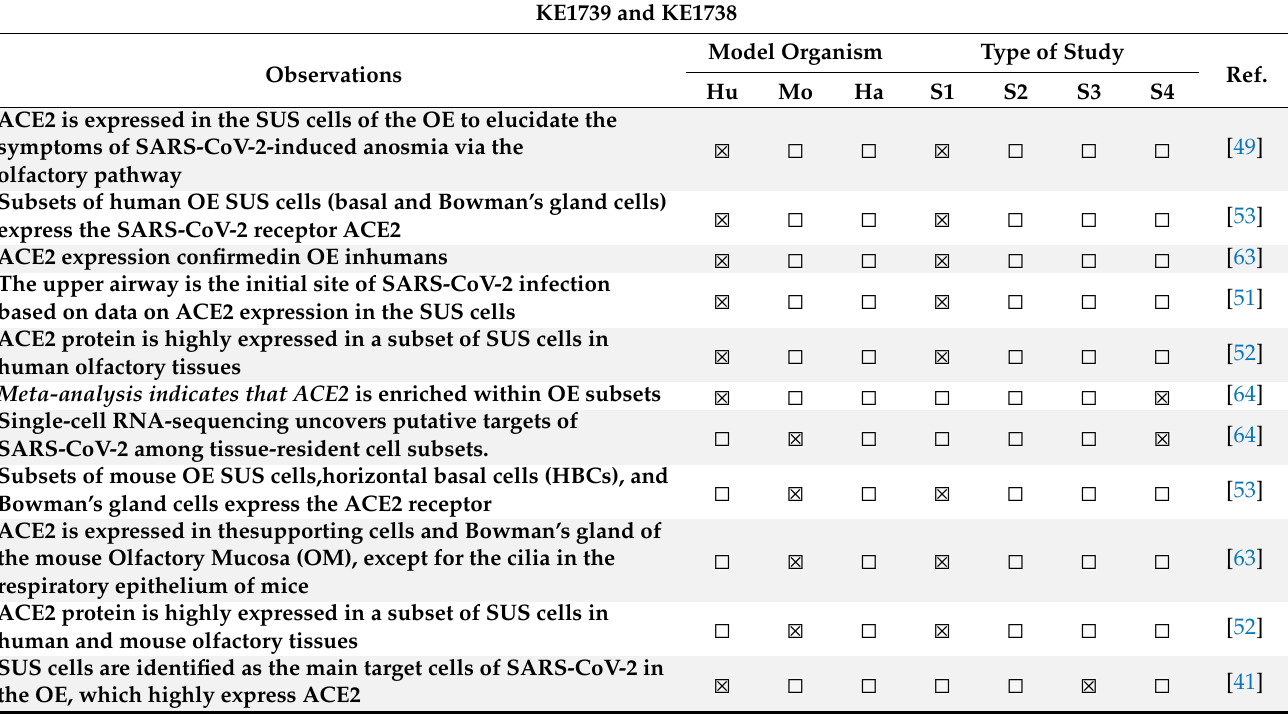
Dpi—day post inoculation; KE—key events.